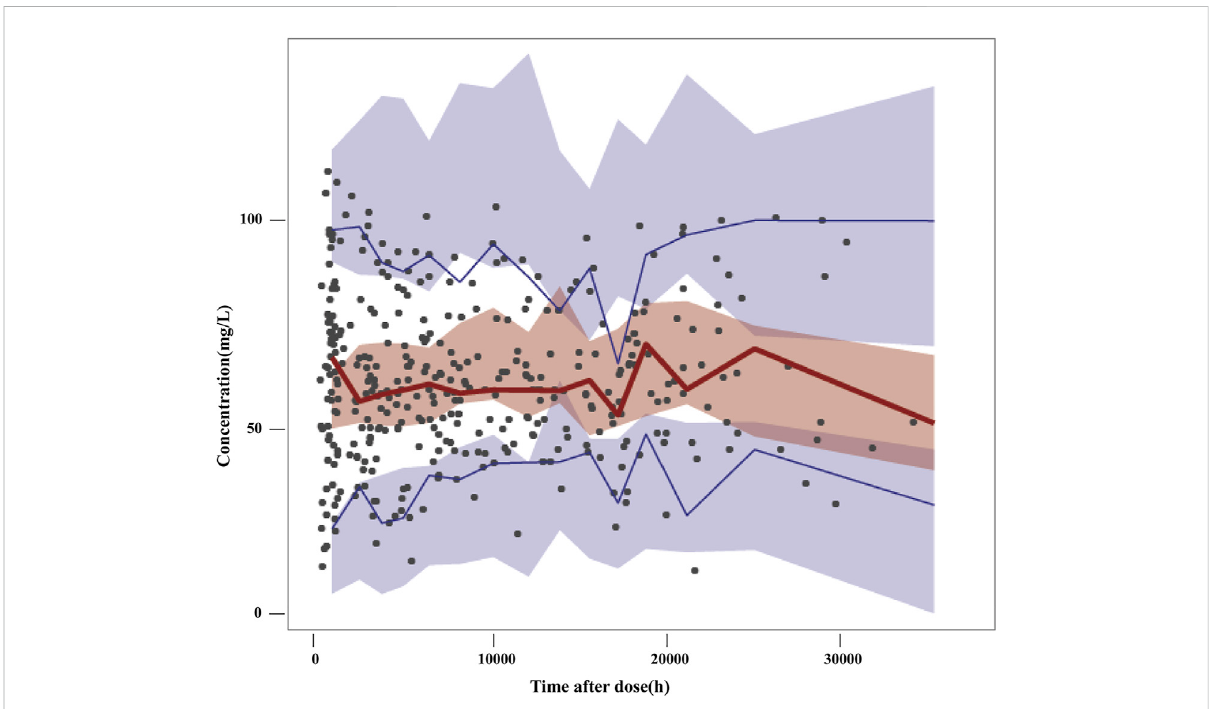
FIGURE 2 Visual predictivechecksof the fi nalmodel.Black dots represent theobserved concentrations; thered line represents the50th percentile ofthe observations; the blue lines represent the 5th and 95th percentiles of the observations. The shaded areas represent the simulation-based 95% con fi dence interval for each